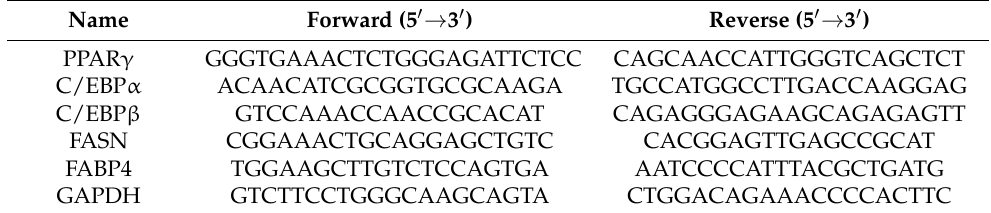
Table 1. Primers used for real-time